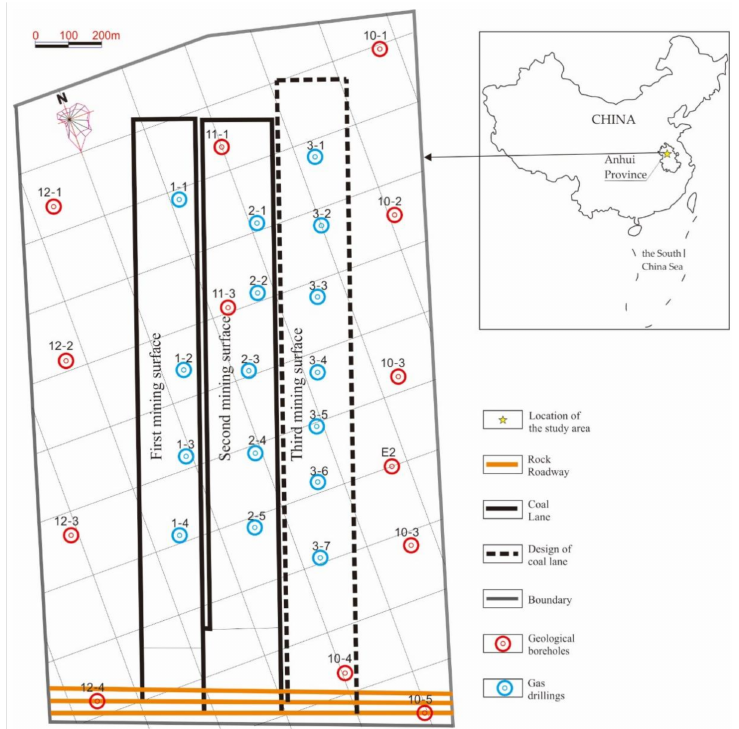
Figure 3. Location of mining engineering in the study